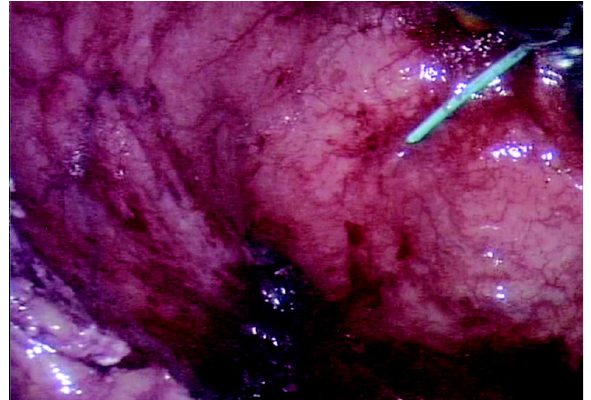
Figure 5 – Final aspect of the resected area closed in 2 planes with intracorporeal continuous suture.